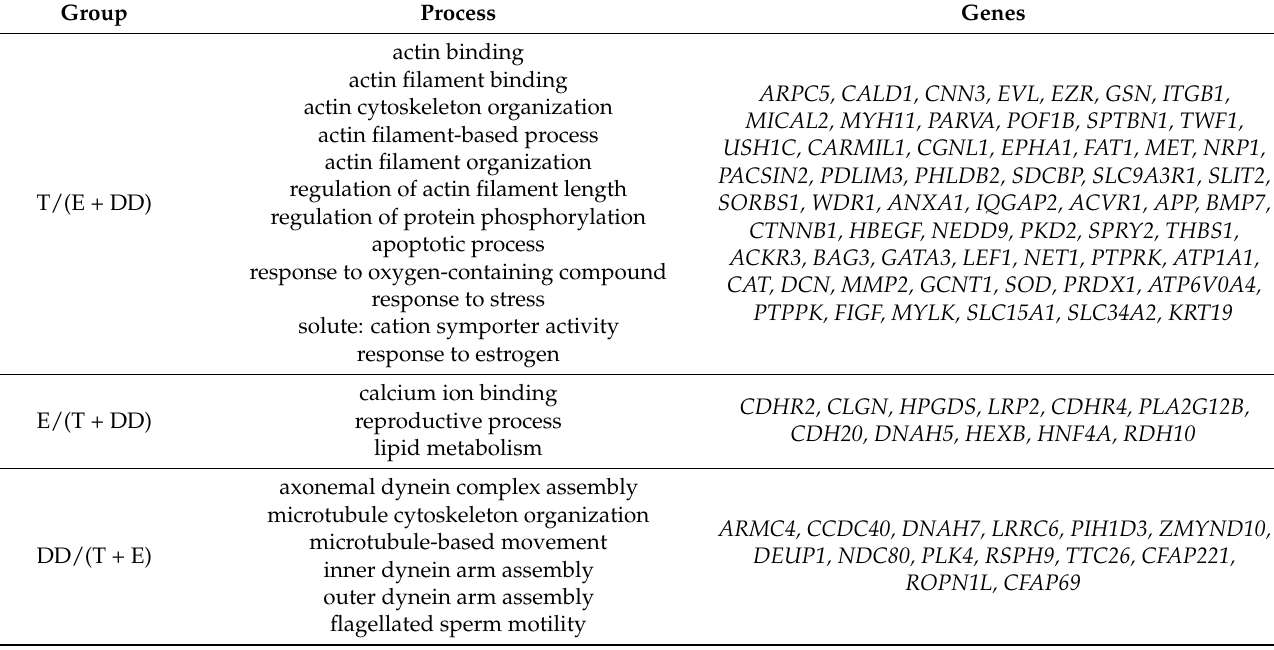
Table 3. Differentially expressed genes (DEGs) associated with molecular processes engaged in sperm motility and grouped into three sets (T/(E + DD), E/(T + DD) and DD/(T + E) based on expression profiles presented in Figure 5.